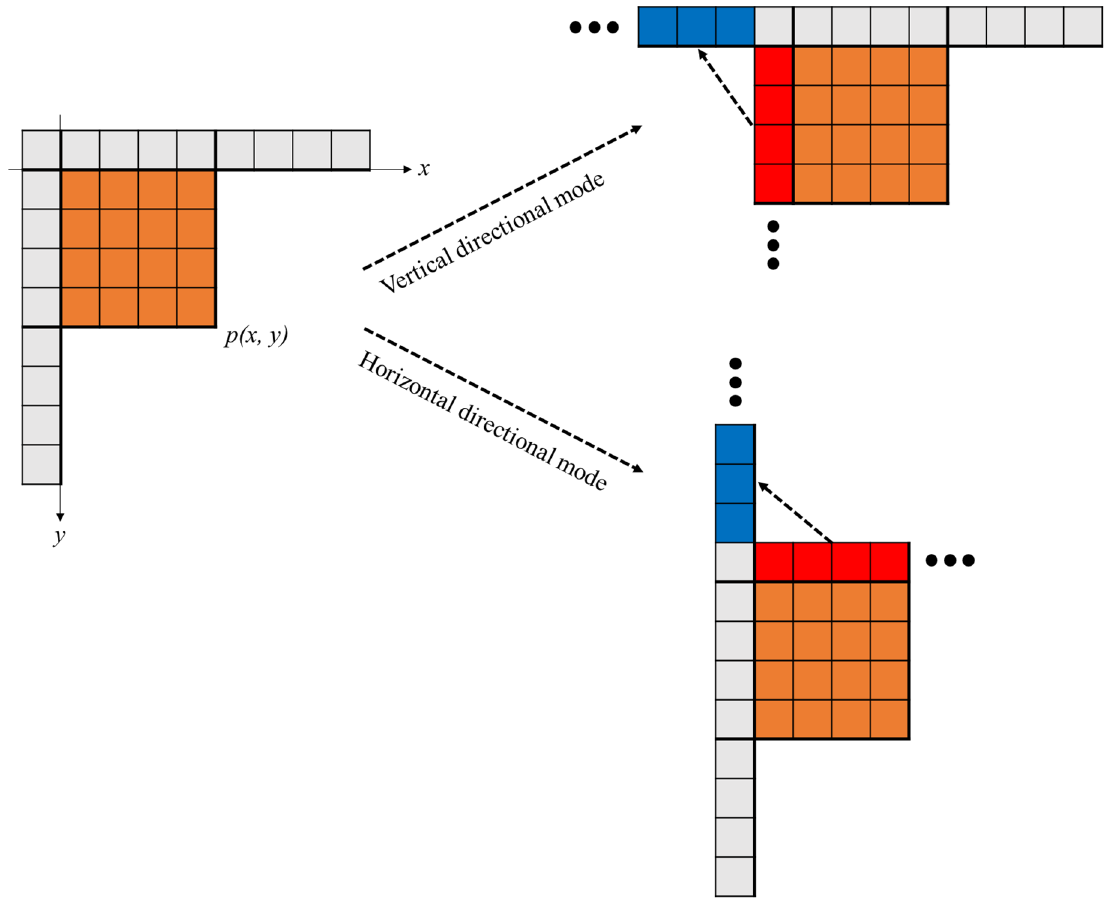
Figure 2. Extrapolation for the horizontal and vertical directional modes.